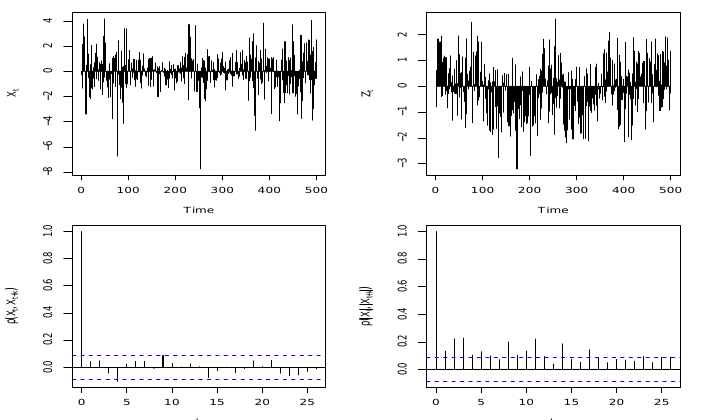
Figure 2. Realizations of length n = 500 of ( X t ) and ( Z t ) for a VT-ARMA(1,1) process with a marginal Student t distribution with ν = 3 degrees of freedom and ARMA parameters α = 0.95 and β = − 0.85. ACF plots for ( X t ) and ( | X t | ) are also